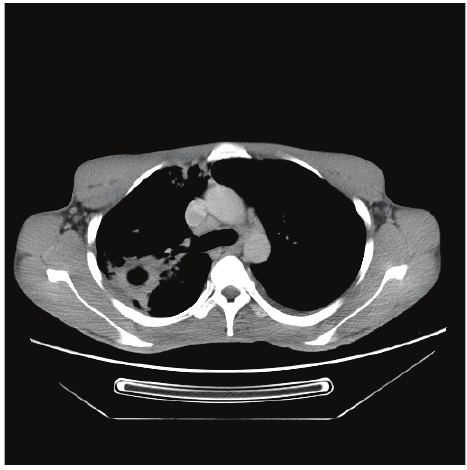
Figure 2: Chest computed scan revealed pleural